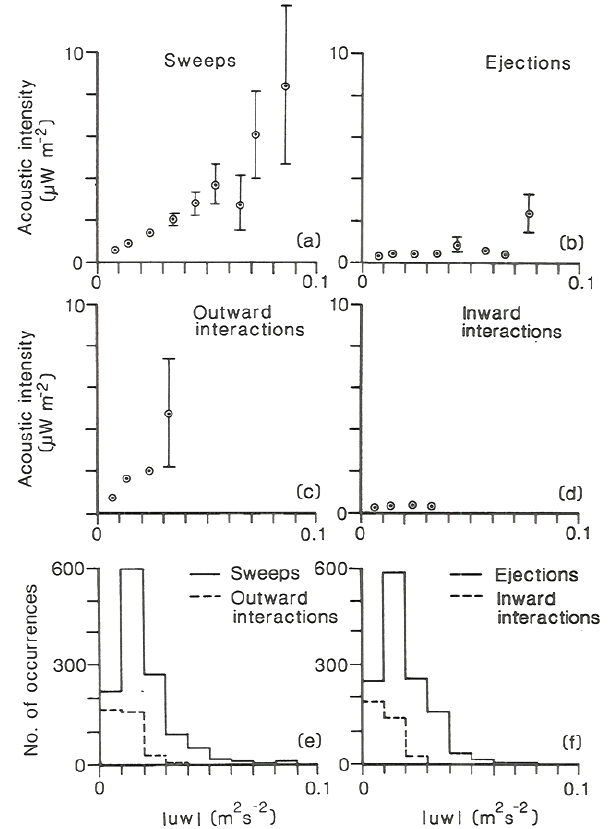
Figure 8. Comparison of the proxy for sediment transport, acoustic intensity, with the magnitude of the kinematic stress, | uw | , due to (a) sweeps, (b) ejections, (c) outward interactions, (d) inward inter- actions and (e, f) the number of events for the four kinematic stress quadrature components. Measurements are from Heathershaw and Thorne